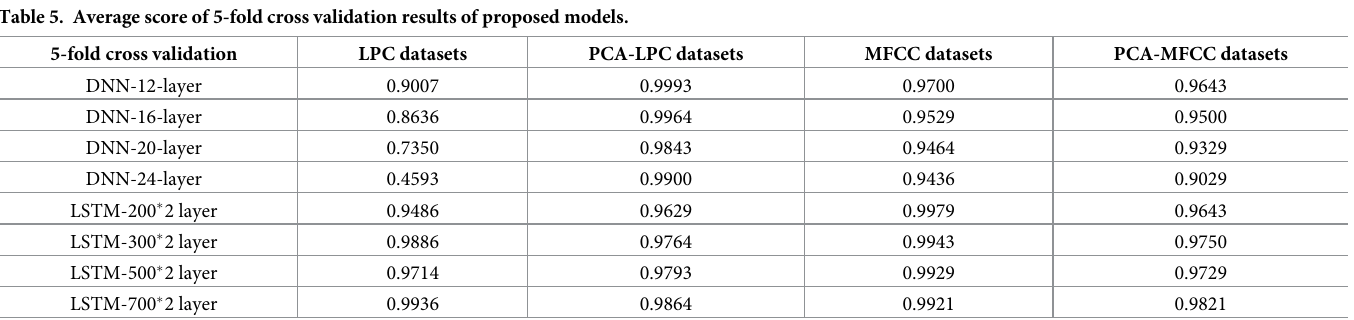
Table 5. Average score of 5-fold cross validation results of proposed models.